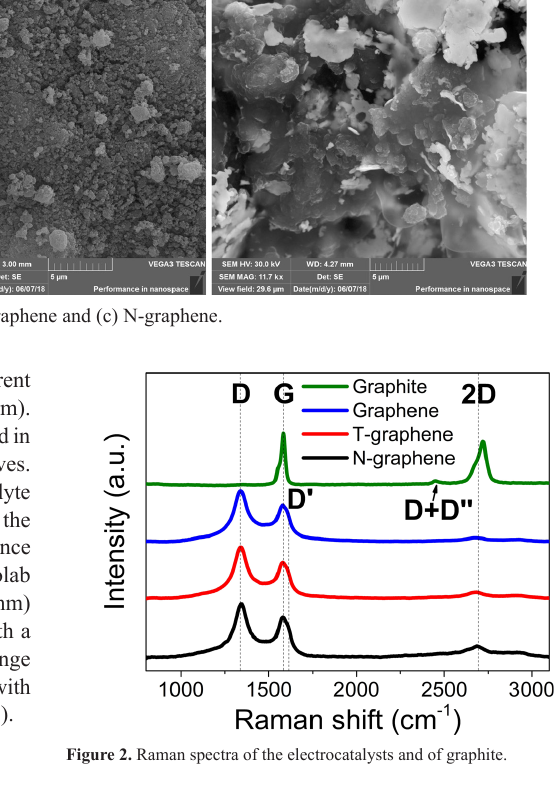
Table 2. Raman bands positions and I